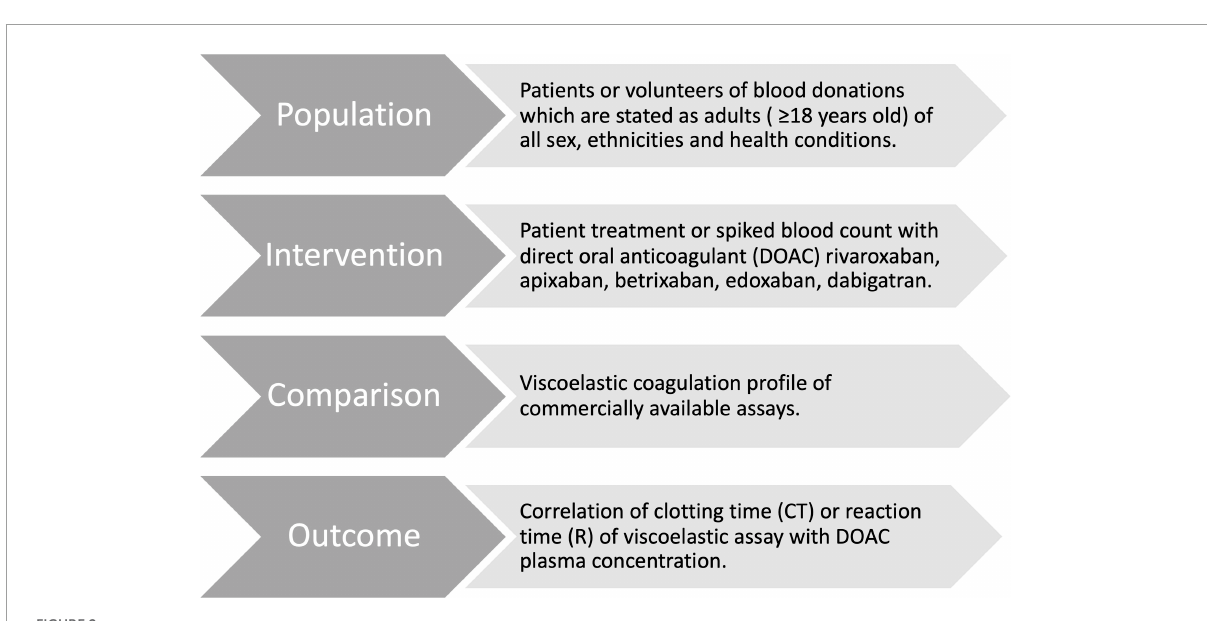
FIGURE2 Clinical questions for evidence-based